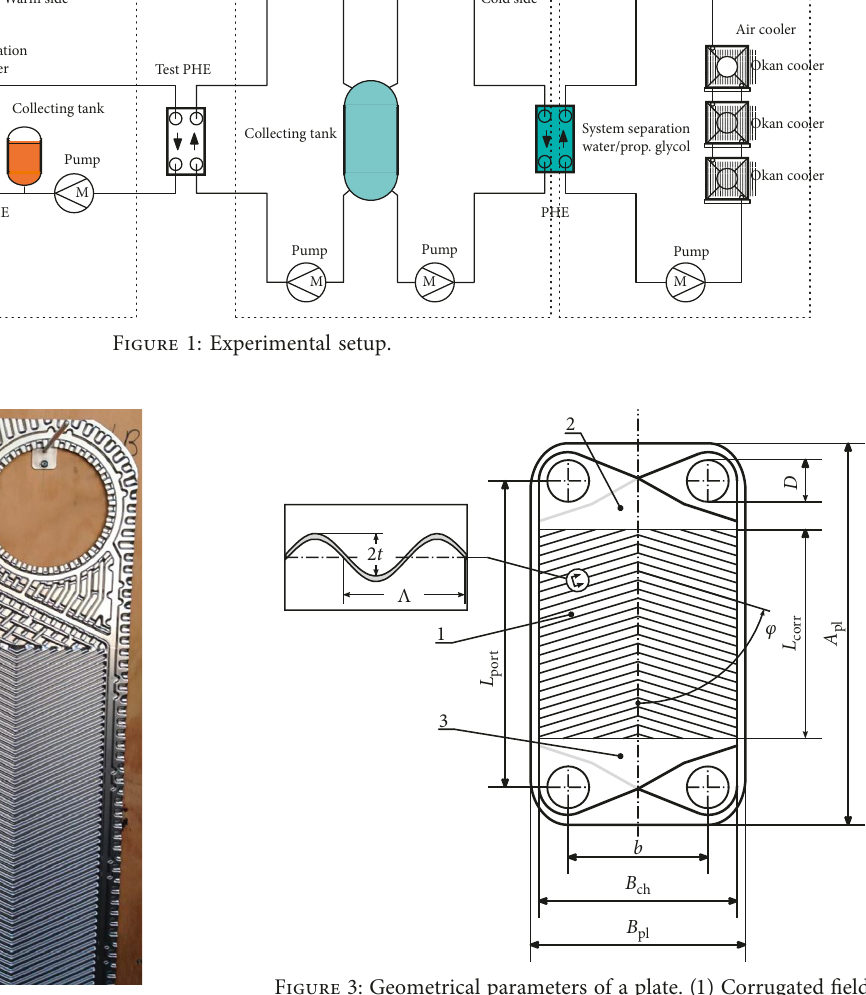
Figure 2: Experimental plate P2.